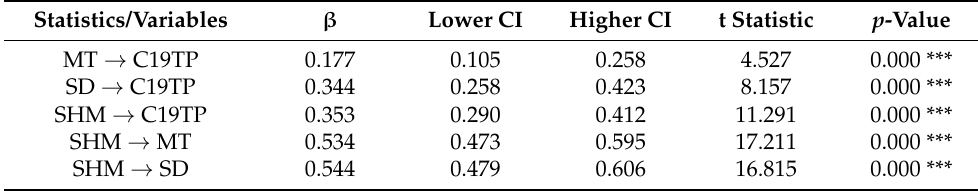
Table 9. Path coefficients.